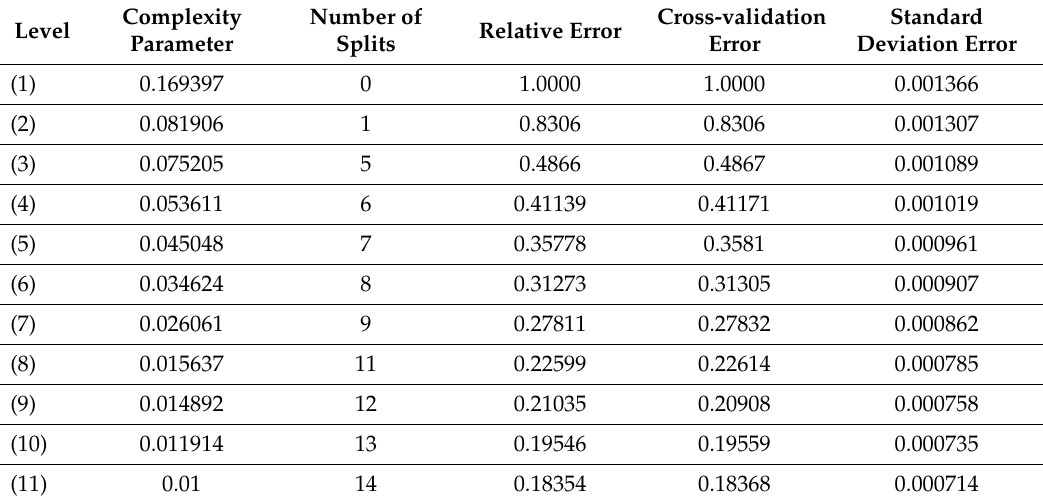
Figure 9. Pruning plot of the DT and its computational process based on relative error and the complexity parameter (CP). Table 4. Pruning table of DT to indicate the errors in each level of the tree.